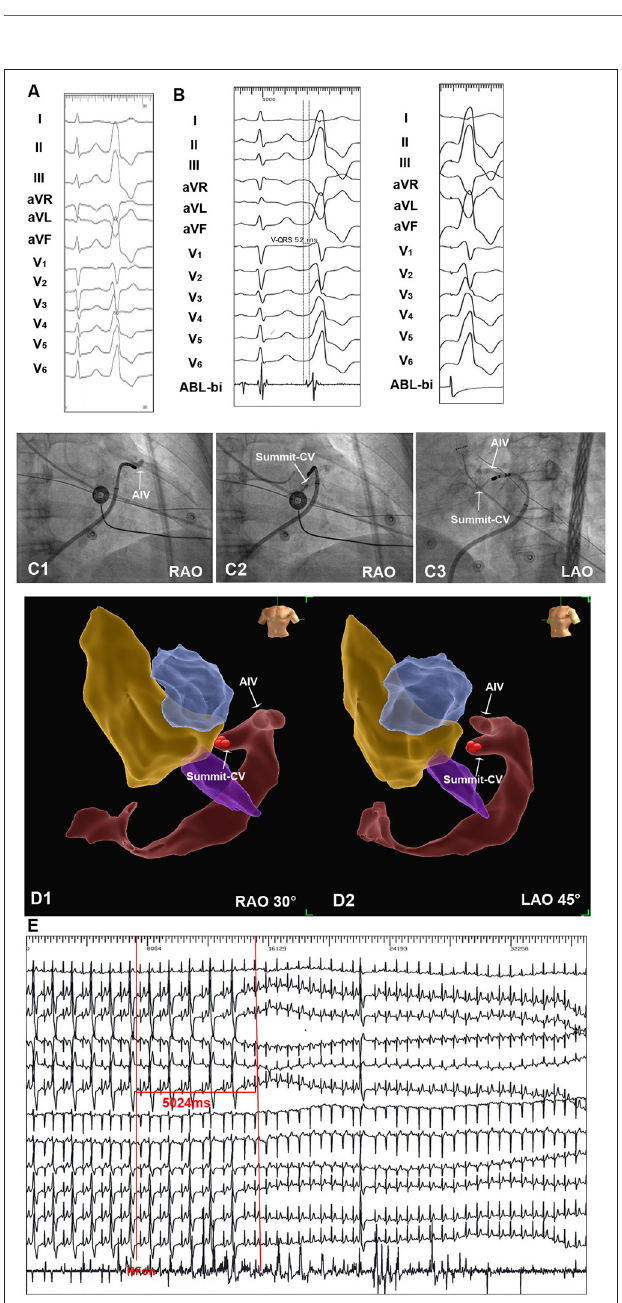
FIGURE 4 | An example of successful ablation of premature ventricular complex (PVC) originating from Summit-CV by SS approach. (A) Twelve-lead ECG 3 morphology of the clinical PVC. The PVC showed R wave in II, III, aVF, V4-V6, rS morphology in lead V1, the precordial transition zone of PVC was earlier than sinus beat. (B) By NS approach, the irrigated catheter could reach the distal portion of GCV. SS approach was then applied in this patient. By SS approach, the irrigated catheter reached the target site in summit-CV. The local ventricular activation time recorded at the summit-CV preceded the onset of the QRS complex by 52ms, and a perfect pace-match was achieved by pacing at summit-CV. (C1–C3) Fluoroscopic view of the target site in summit-CV. (D1,D2) Three-dimension view of target site in Summit-CV. (E) Radiofrequency energy delivered on target site for 5 seconds led to an acute disappearance of target PVCs.